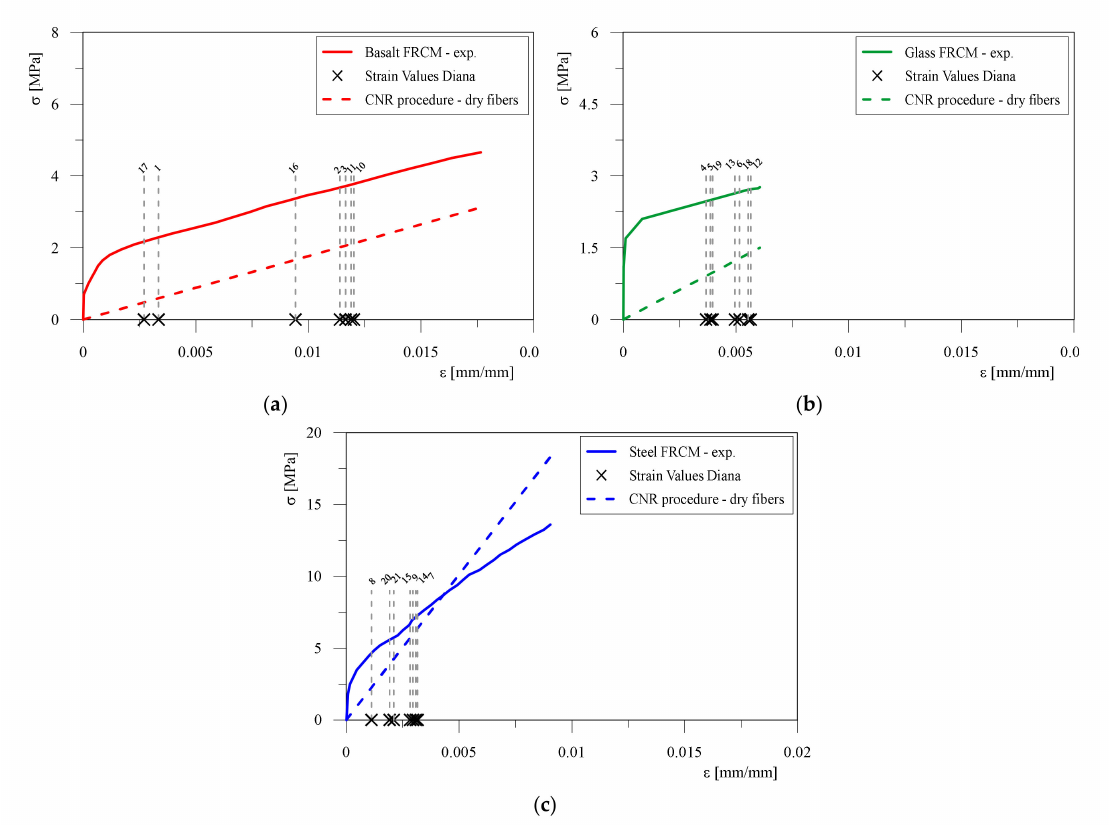
Figure 5. Evaluation of fibers strains in the strengthened walls at failure and comparisons with the constitutive laws: ( a ) basalt; ( b ) glass; ( c )